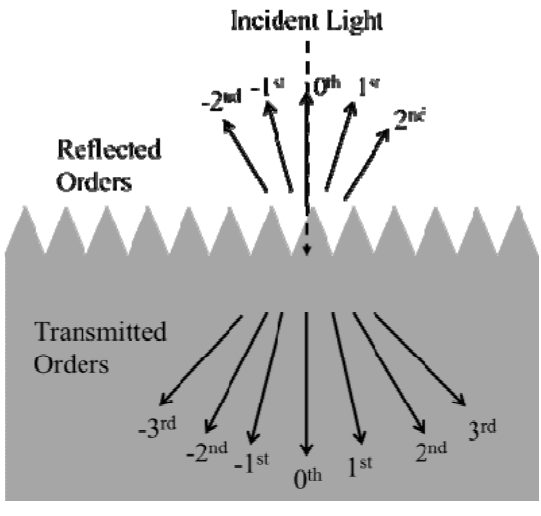
Figure 4. Diffraction orders on a 1-D grating at normal